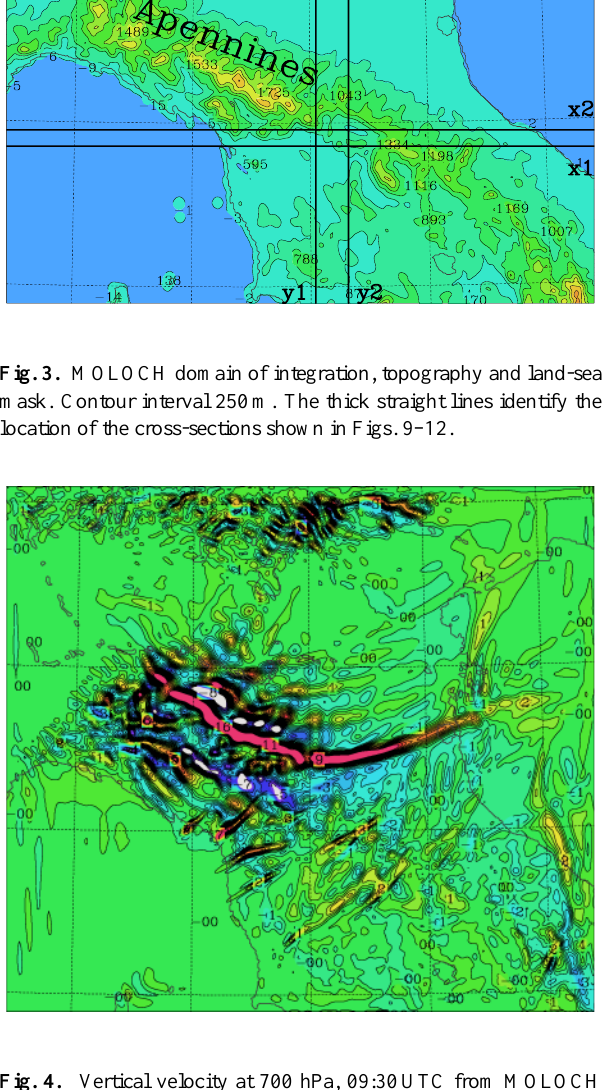
Fig. 4. Vertical velocity at 700 hPa, 09:30UTC from MOLOCH simulation. Contour interval 0.5ms − 1